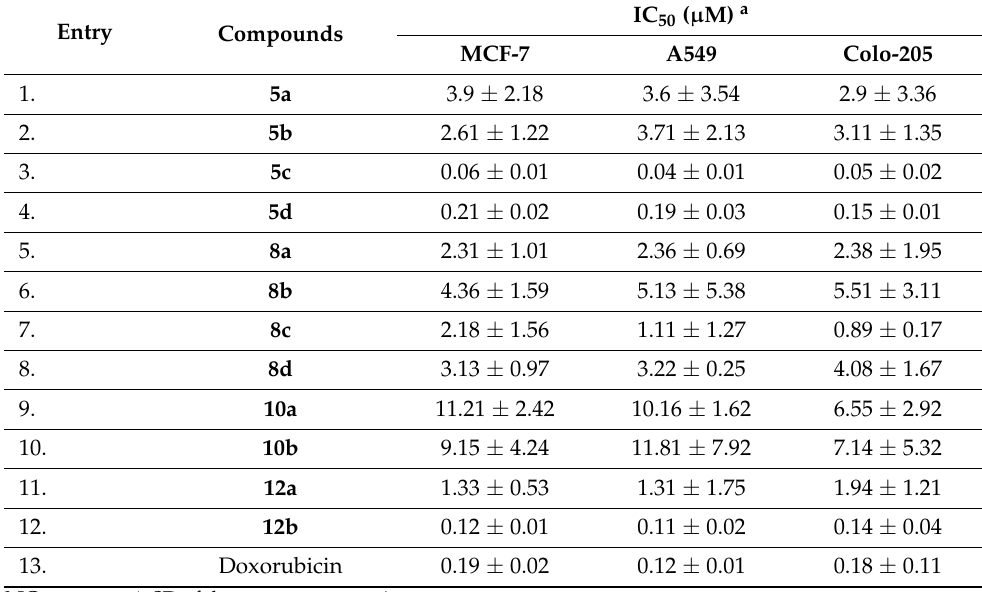
Table 4. The in vitro activity of derivatives 5, 8, 10, and 12 (expressed as IC 50 ( µ M)) against MCF-7, A549, and Colo-205 human cancer cell